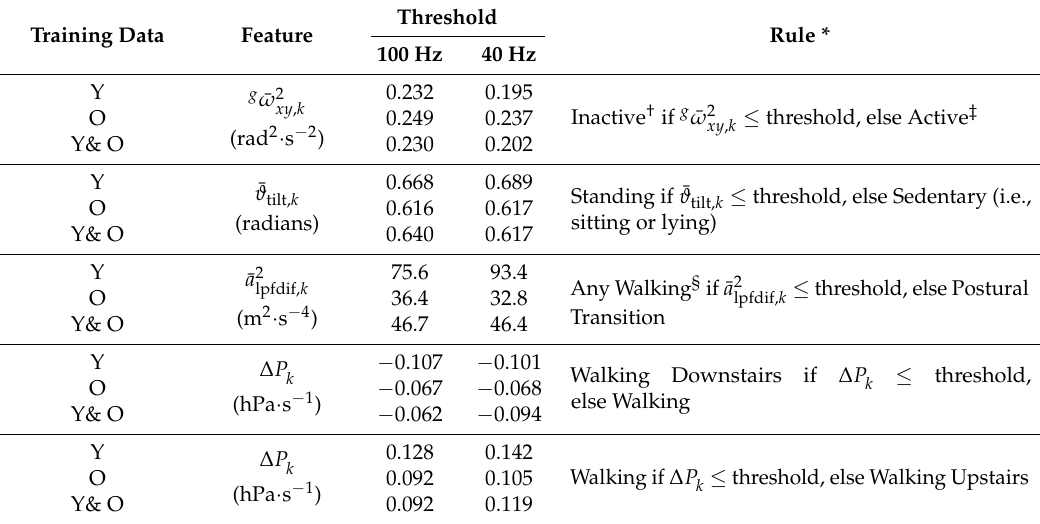
Table 5. Comparison of thresholds when HMHA recognition were developed with the Best Features at different sampling